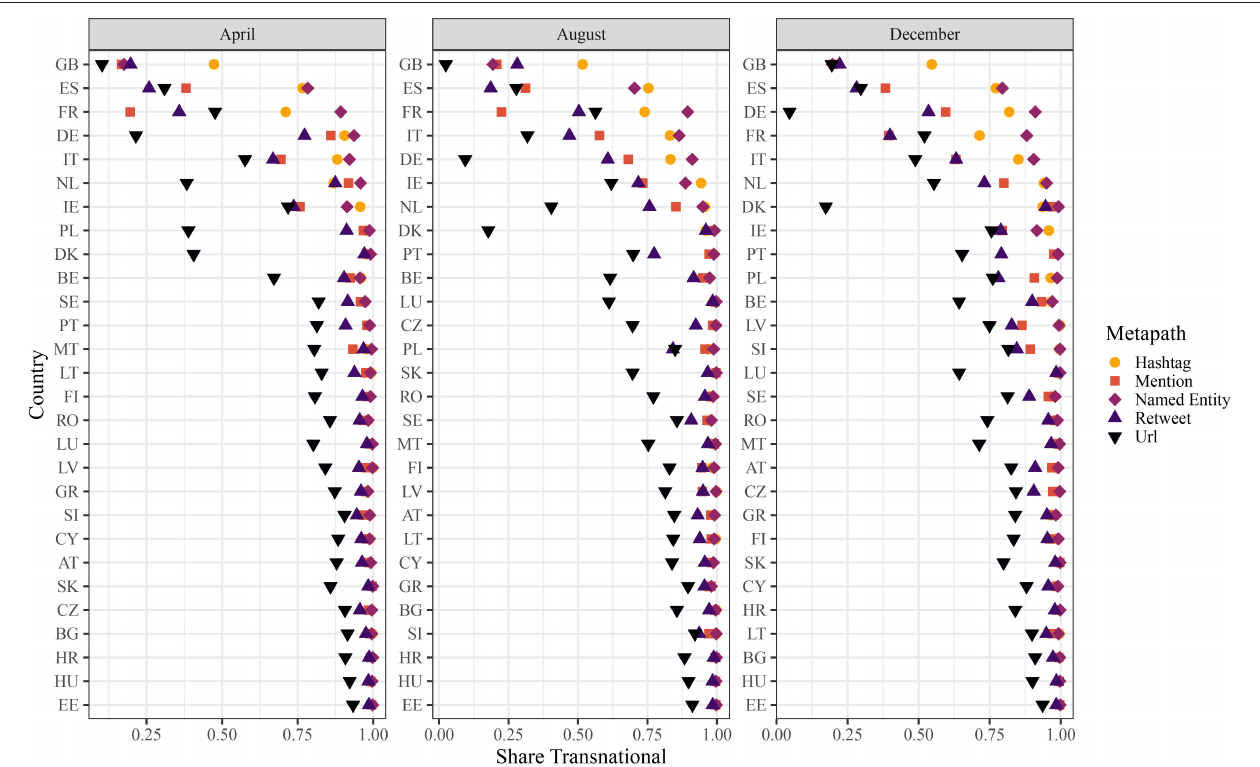
FIGURE 4 | Country-wise shares faceted by month. The point shapes and colors shows the respective type of meta path. The countries are ordered according to their average share of transnational communication for each month